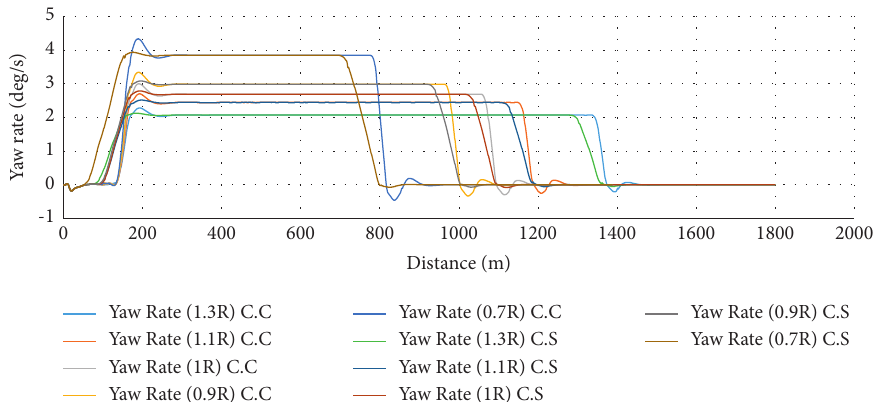
Figure 20: Yaw rate versus the path length for various radii of simple and spiral horizontal curves; C.C is the simple horizontal curve, and C.S is the spiral horizontal curve.